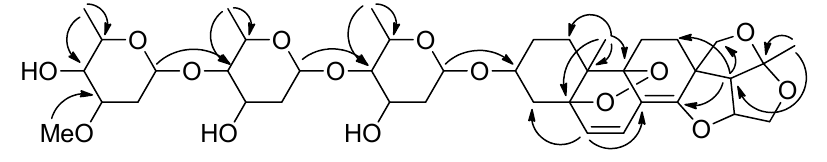
Figure 2. Key HMBC correlations (H → C) of 1 .